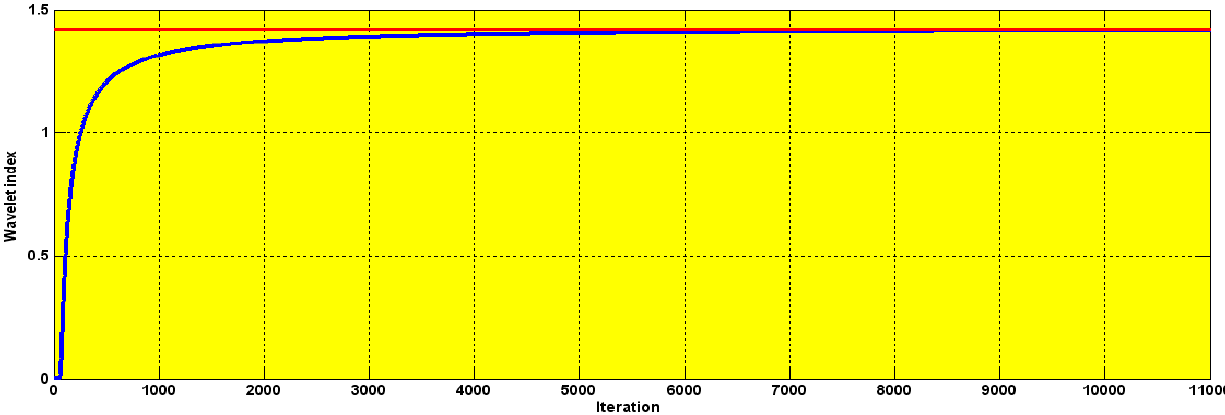
Figure 16. Experimental (red) and simulation comparison of the healthy I.M wavelet index.